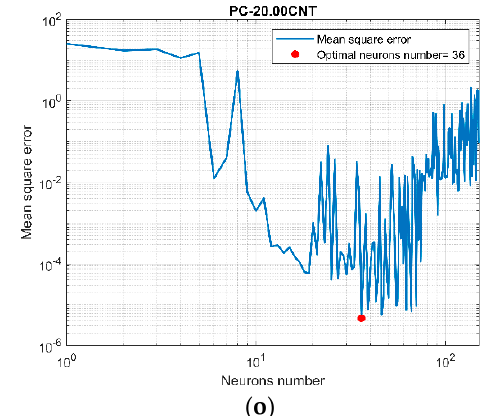
Figure 3. Logarithmic scale plot showing the hyper-parameter optimization process via the hold-out validation method. Figures show the optimal values (red points) of the number of neurons of multilayer perceptron (MLP) from the lowest carbon nanotube (CNT) load ( a ) up to the highest load ( o ).